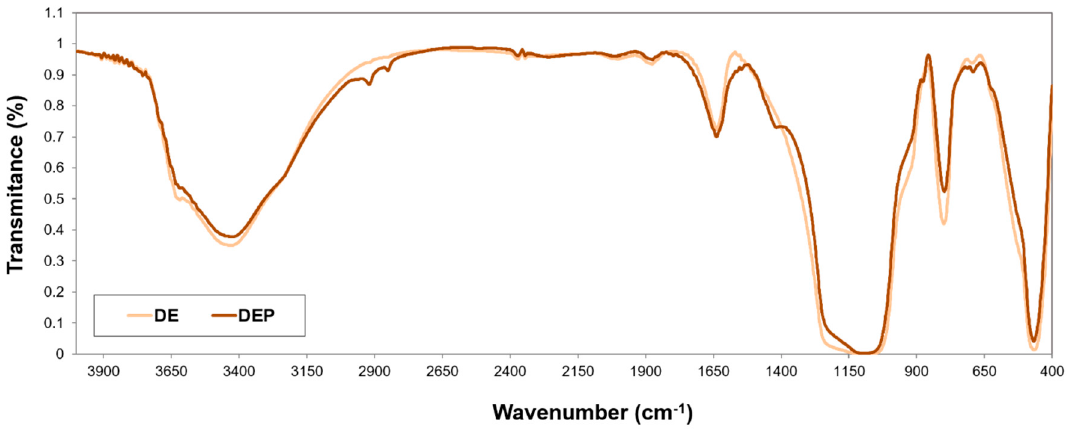
Figure 3. FT-IR spectrum of DE (diatomaceous earth) and DEP (diatomaceous earth/peat, 3:1)